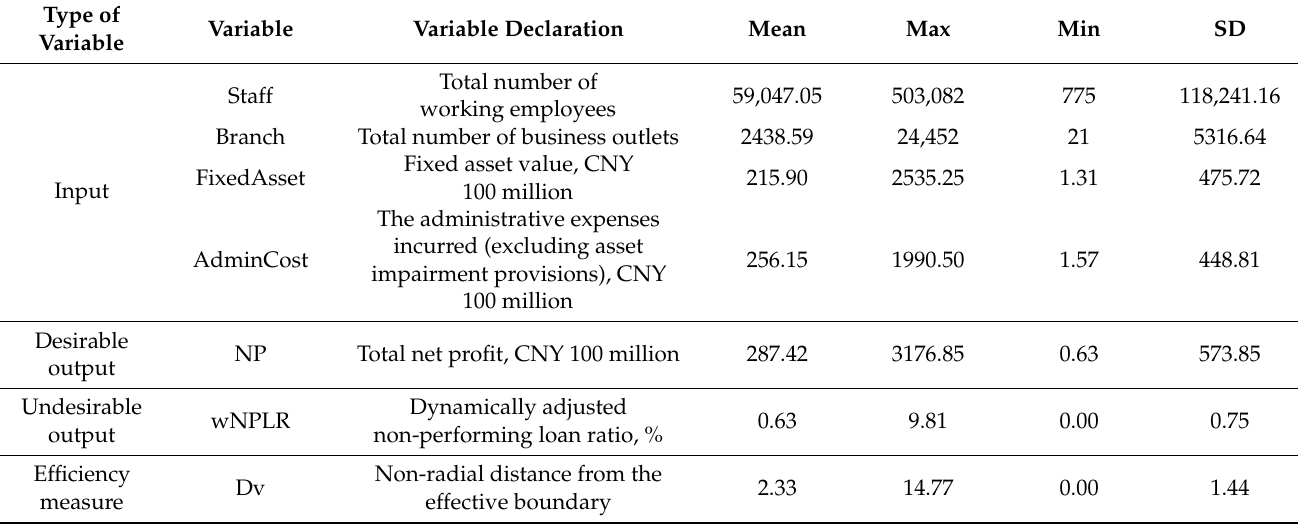
Table 4. Descriptive statistics for operational efficiency